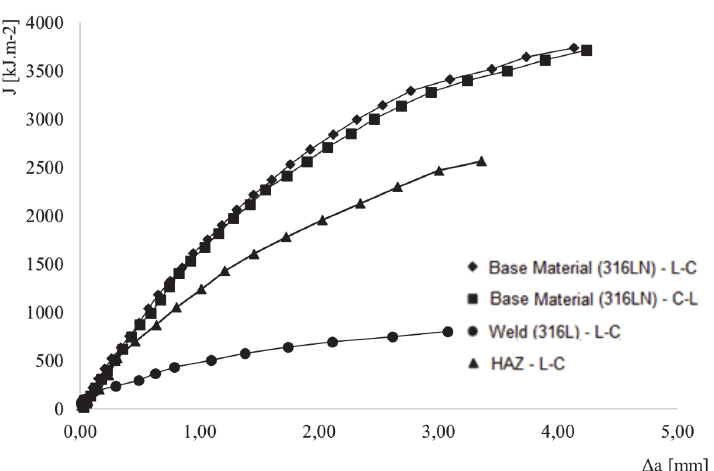
Figure 2: Typical J-R curves for different zones in the welded